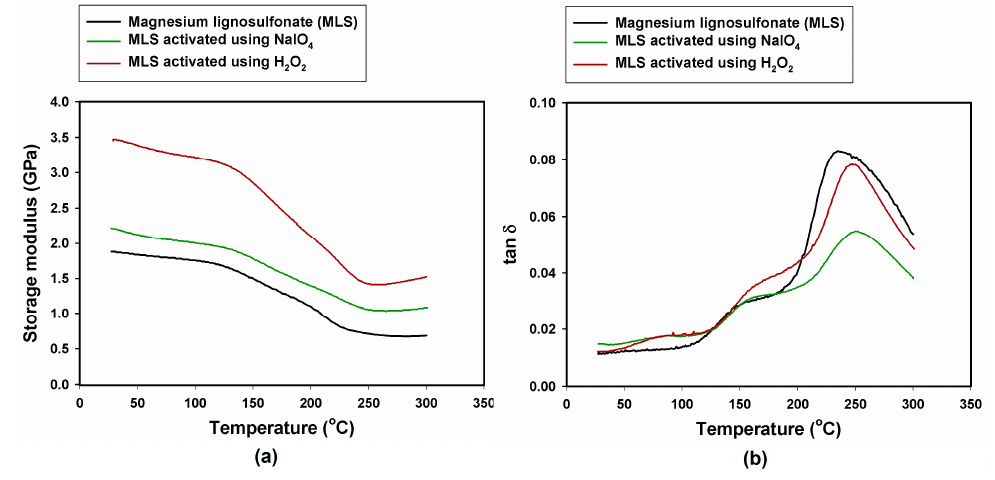
Figure 6. Mechanical-thermal properties of composites with lignosulfonates: ( a ) storage modulus; and ( b ) loss factor.